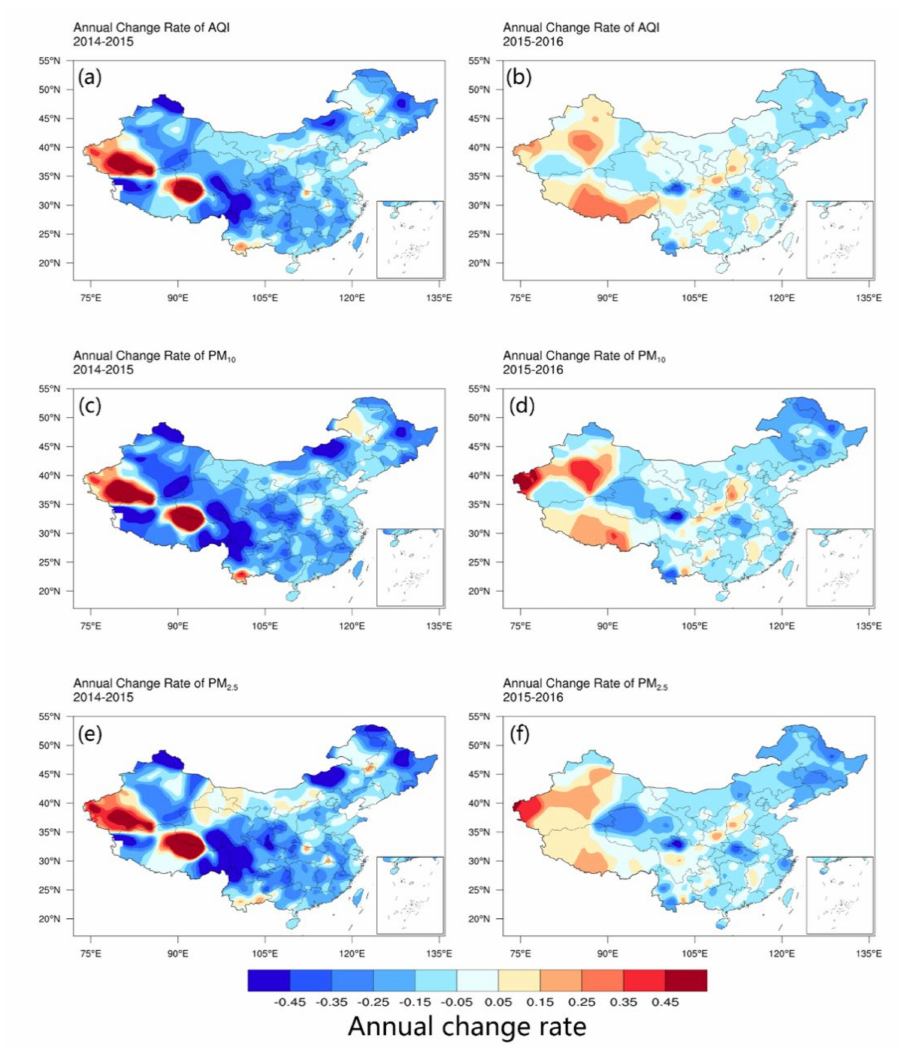
Figure 5. The annual change rate of ( a – b ) AQI, ( c – d ) PM 10 concentration, and ( e – f ) PM 2.5 concentra- tion from 2014 to 2015, and from 2015 to